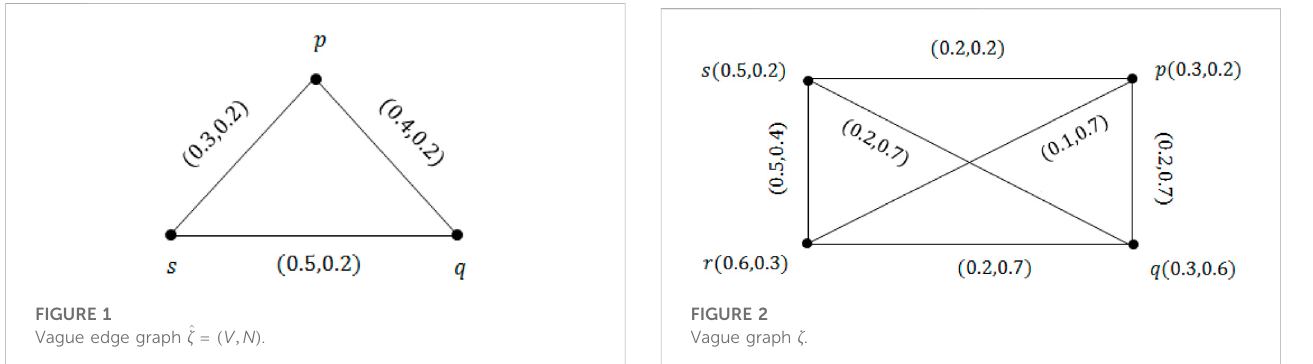
FIGURE 2 Vague graph ζ .